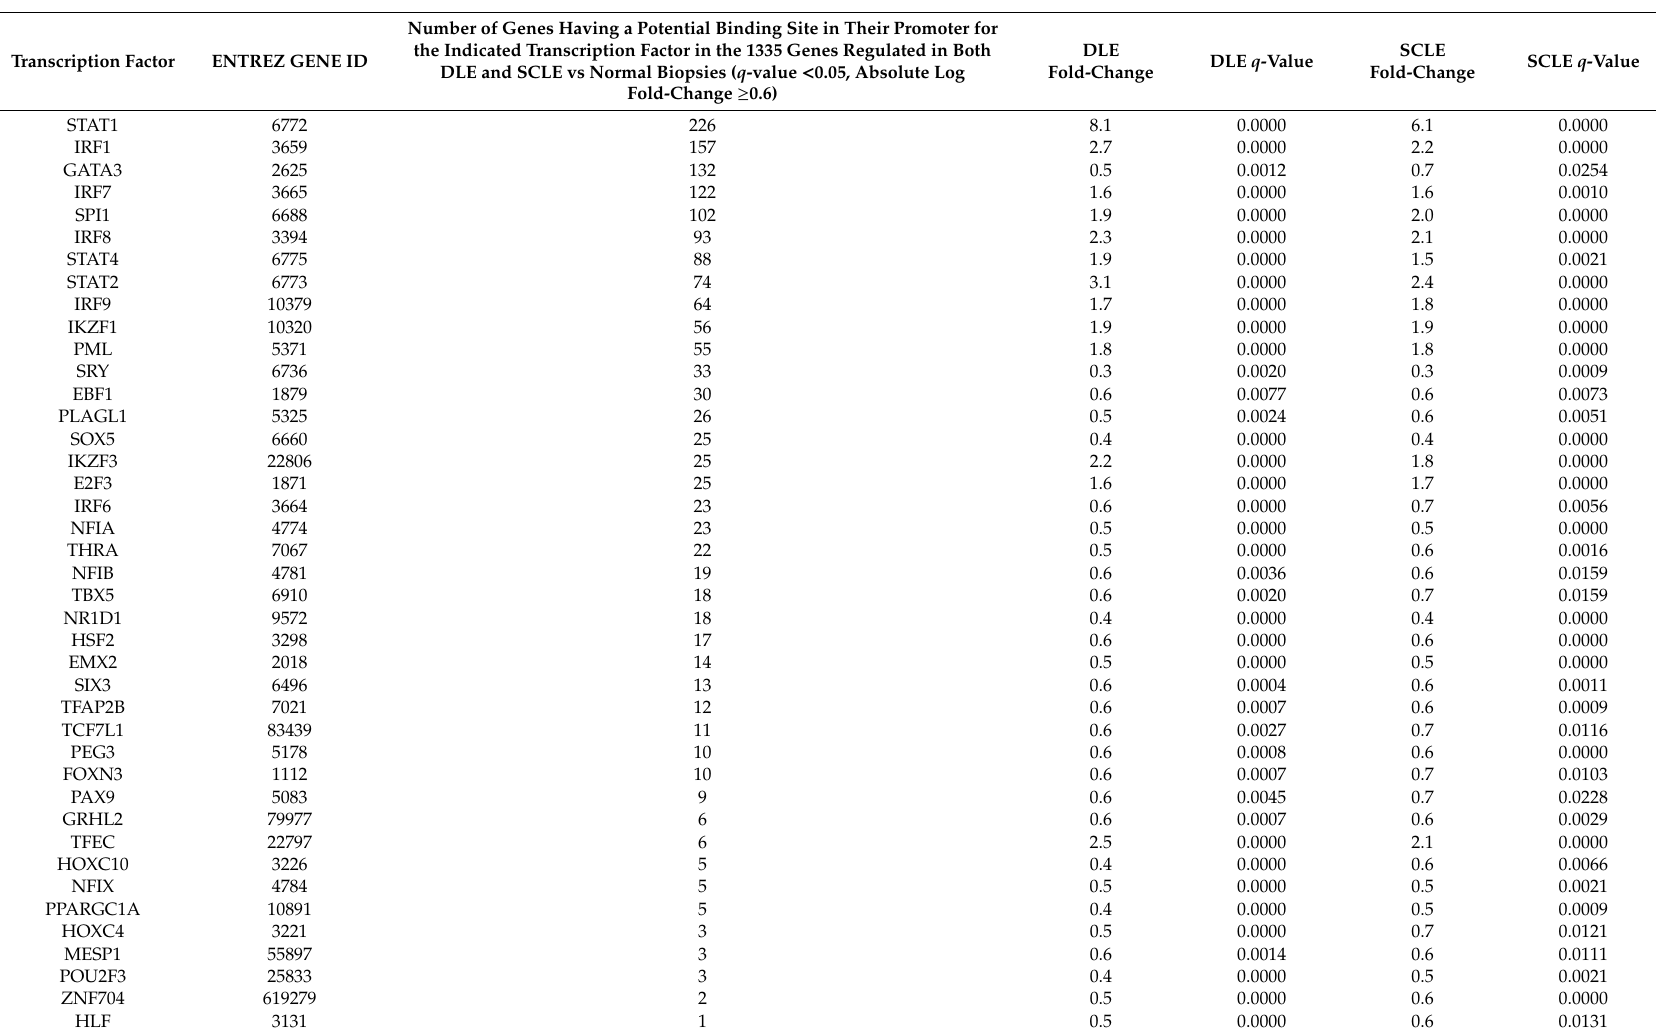
Table 3. Transcription factor (TF) analysis as assessed by